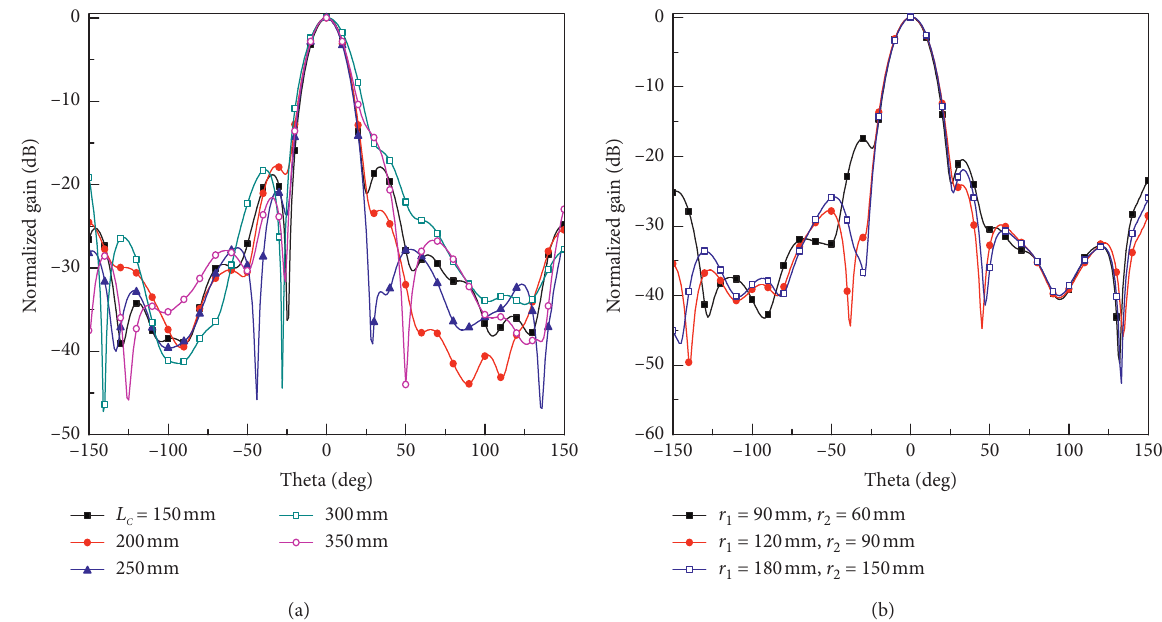
Figure 10: Effect of nose-cone parameters (a) L